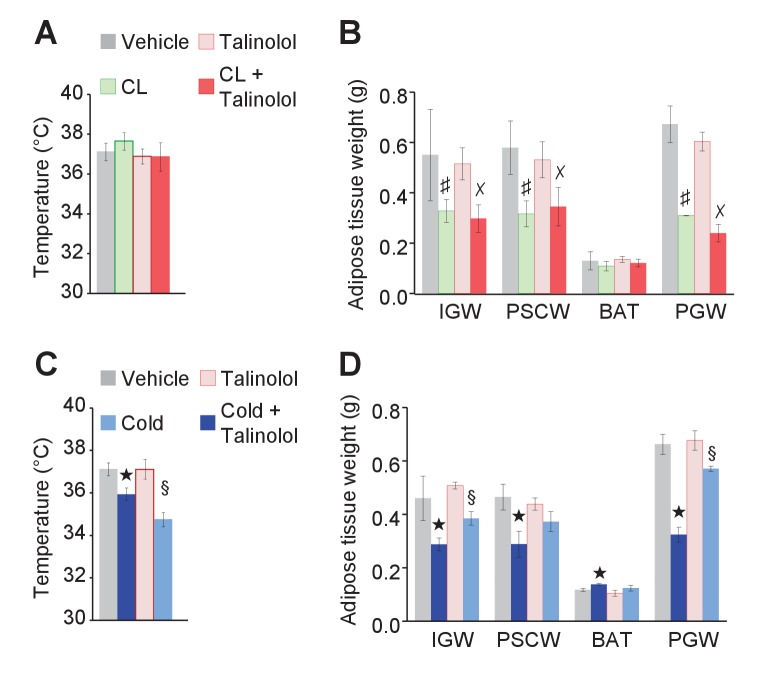
Adrb1 is required for cold-induced beiging.(A) Rectal temperatures from two-month-old male mice treated with vehicle or talinolol (1 mg/Kg/day) for five days. Mice were then maintained at room temperature or treated with CL (1 mg/Kg/day) for seven days (n = 10/group). (B) Adipose tissue weights from mice described in (A). ♯p<0.001 CL-treated mice compared to vehicle-treated mice. ✗p<0.001 unpaired t-test, two tailed: CL +talinolol- compared to vehicle-treated mice. (C) Rectal temperatures from two-month-old male mice treated with vehicle or talinolol (1 mg/Kg/day) for five days. Mice were then maintained at room temperature or cold exposed (6.5°C) for seven days. ★p<0.001 unpaired t-test, two tailed: cold-exposed compared to room temperature vehicle-treated mice. §p<0.001 unpaired t-test, two tailed: cold exposed + talinolol-treated compared to cold-exposed mice. (D) Adipose tissue weights from mice described in (C). ★p<0.001 unpaired t-test, two tailed: cold-exposed compared to room temperature vehicle-treated mice. §p<0.001 unpaired t-test, two tailed: cold-exposed + talinolol-treated compared to cold-exposed mice.